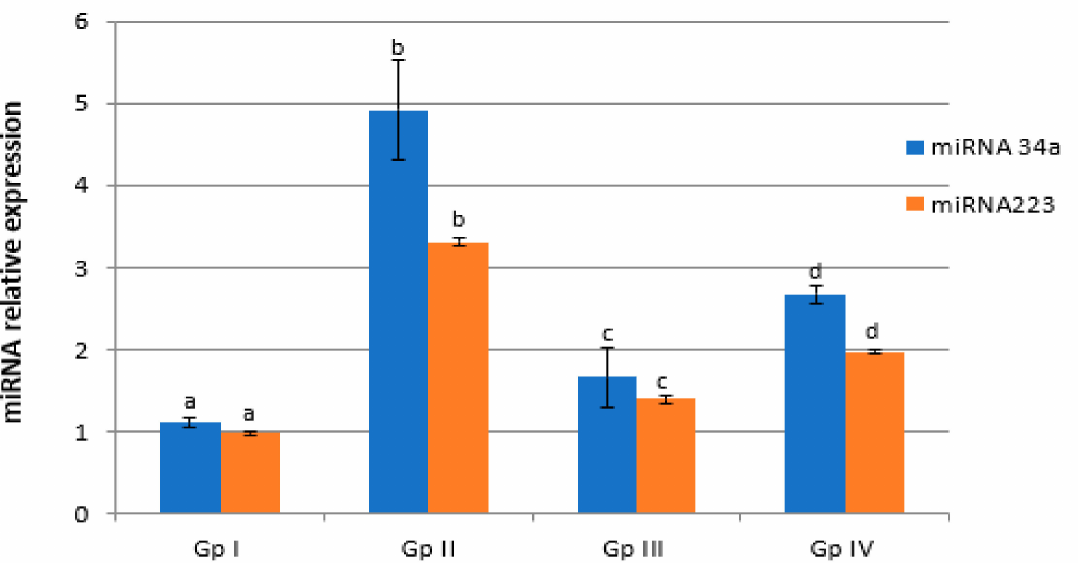
Figure 5. Effect of MESC and silymarin on the expression levels of liver miRNA-34a and miRNA-233 gene in paracetamol-treated rats. Data are presented as fold increases with respect to control values, considering the normal control values equals to a. Data followed by the same letter within the same parameter are not significantly different at p ≤